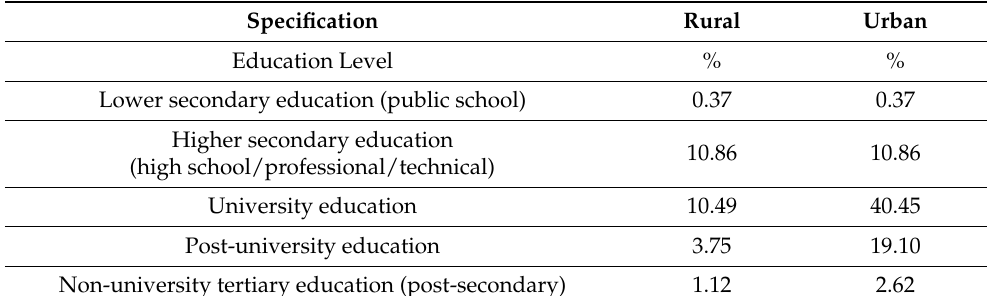
Table 2. The distribution of completed level of education, depending on the housing environment,